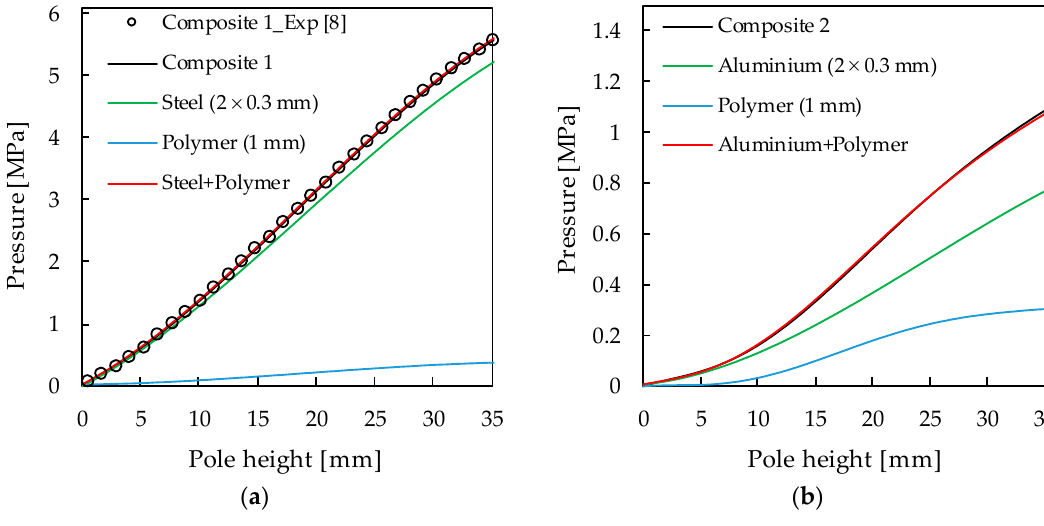
Figure 5. ( a ) and ( b ) Pressure vs. pole height evolutions for the: (i) composite materials (black lines); (ii) constituent outer layers of steel and aluminium (green lines); constituent inner layer of polymer (blue lines); (iii) sum of the results of independent constituents: outer metallic layer + polymeric core results (red lines) and data experimentally obtained by Miranda et al. [8] (circles). Note: the software Web Plot Digitizer was used to obtain an excel file with the data points, from the published experimental curves [21].